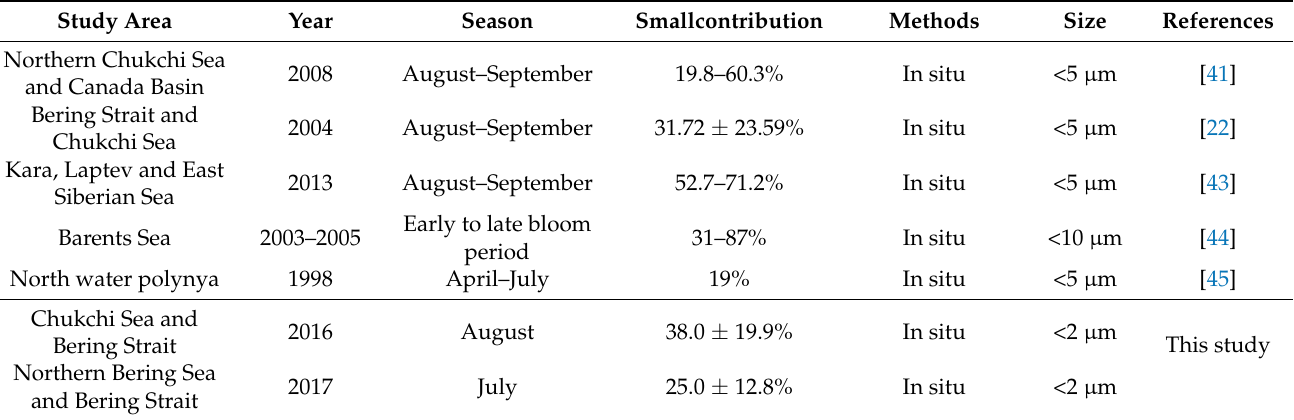
Table 4. Small phytoplankton contributions to the total primary production in the Arctic